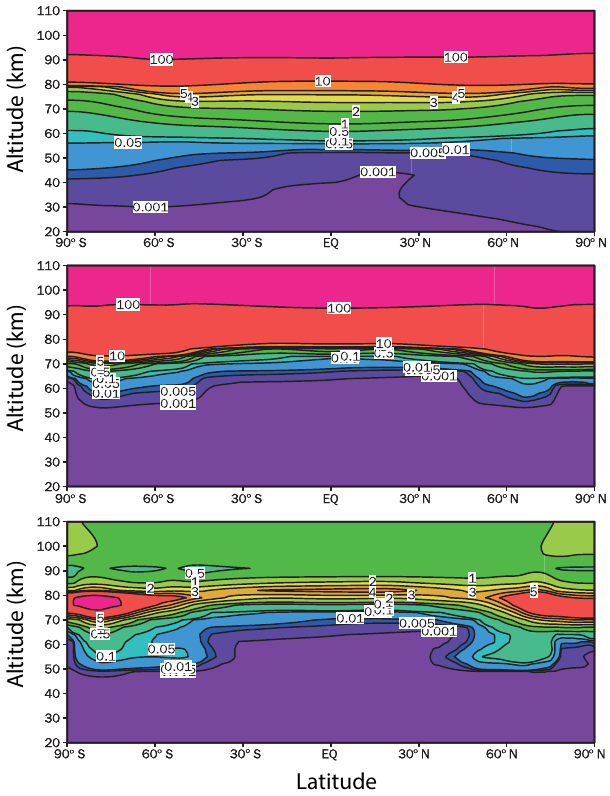
Figure 1. Top: annual average electron concentration for 2013 from the standard WACCM model (in 10 2 electronscm − 3 ). Middle: an- nual average electron concentration for 2013 from WACCM-SIC model (in 10 2 electronscm − 3 ). Bottom: annually averaged electron scaling factor for